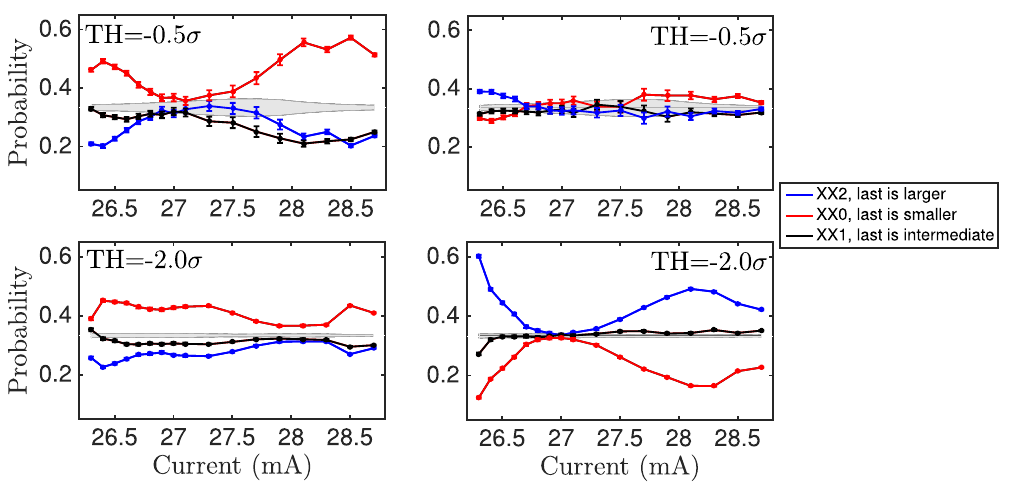
Figure 5. Probabilities of the forecasting time intervals combinations XX 2 = 012 + 102, XX 1 = 021 + 201, and XX 0 = 210 + 120. These combinations highlight the fact that, independently of the two preceding time intervals, the last one tends to be larger ( XX 2) or shorter ( XX 0) before the transition in the dual-dynamics regime. These temporal correlations are lost in the well-developed-LFFs regime. Left row corresponds to shallow-to-deep transition. Right row corresponds to deep-to-shallow